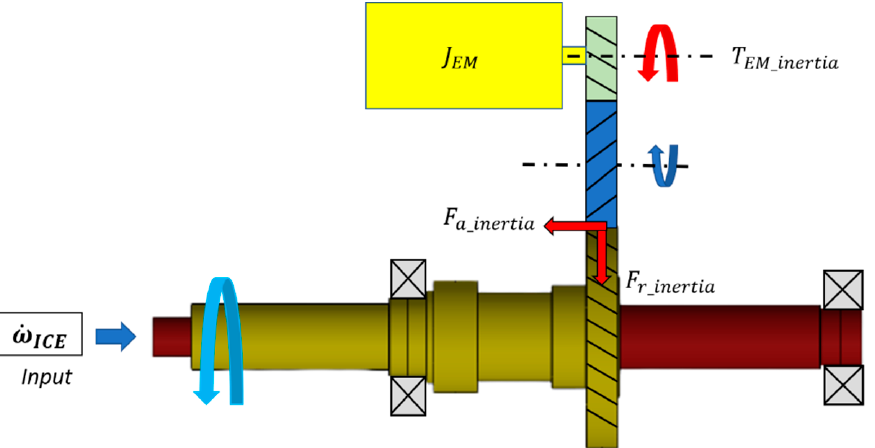
Figure 14. Transfer function block used to calculate the displacement.